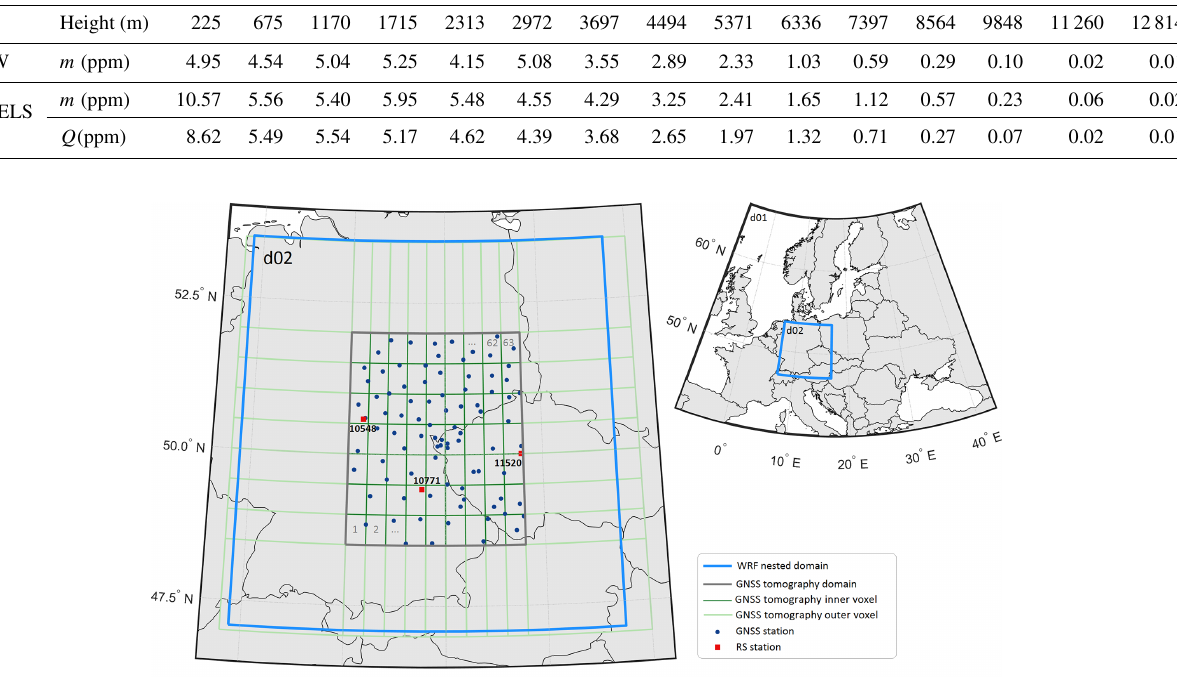
Table 1. A priori model error ( m ) and dynamic disturbance noise values ( Q ) as obtained by comparison of the a priori model data with radiosonde data for each level of the TUW and WUELS tomography model.